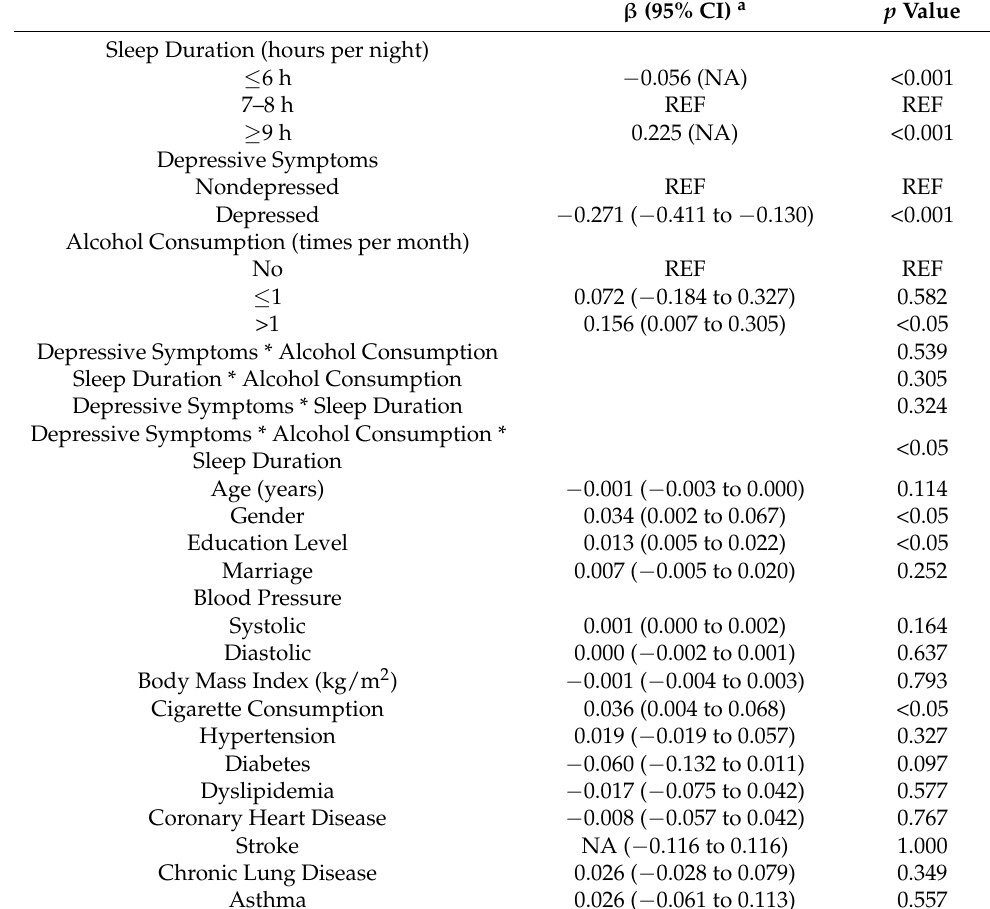
Table 3. Mean difference in overall rate of change in cognitive decline during follow-up using generalized estimating